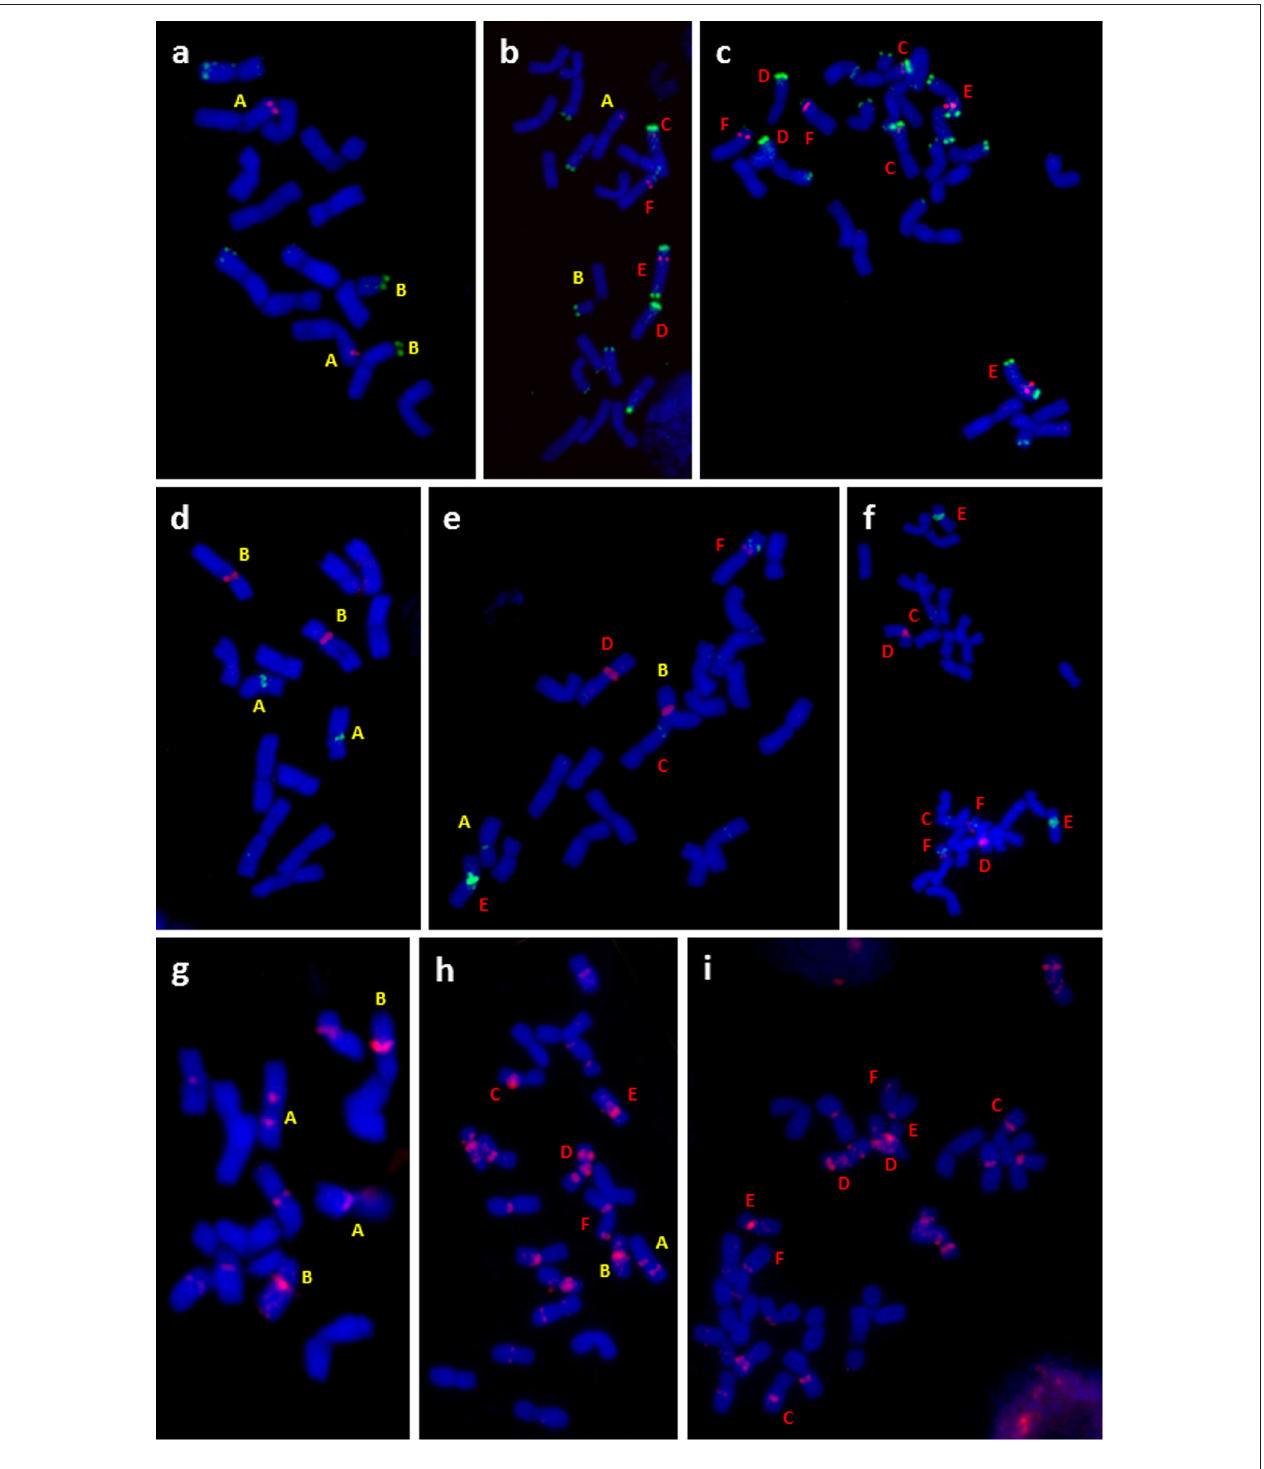
FIGURE 4 | Cytogenetic analysis of diploid F. pratensis (A,D,G), triploid hybrid (B,E,H), and tetraploid F. apennina (C,F,I). FISH was done on metaphase spreads with probes for: (A,B,C) tandem repeats fpTR12 (green color) and fpTR4 (red color), (D,E,F) fpTR15 (green color) and 45S rDNA (red color) and (G,H,I) fpTR7 (red color). Chromosomes with unique fluorescent signals present in diploid F. pratensis , tetraploid F. apennina and their triploid hybrid are marked by letters. Chromosomes were counterstained with DAPI (blue color).